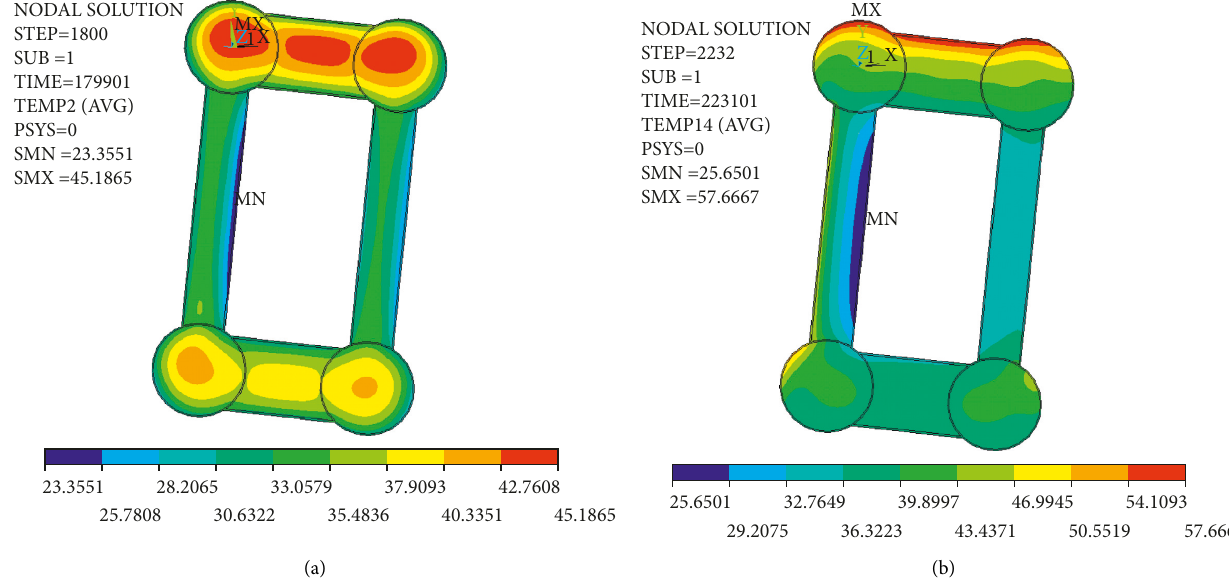
Figure 23: The temperature field nephogram of four-limb truss section: (a) 2 am and (b) 2 pm.